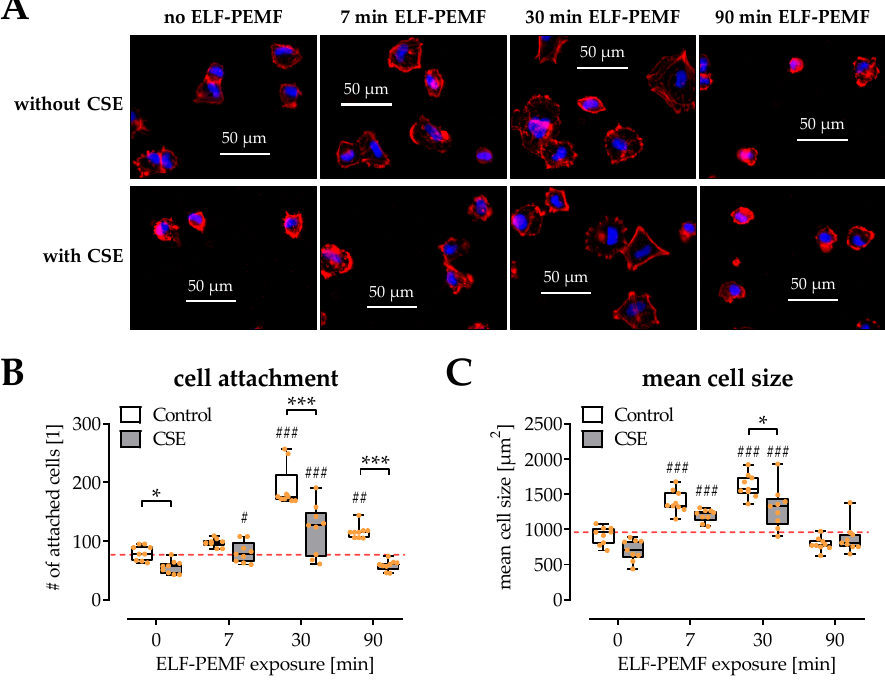
Figure 2. Influences of 16 Hz ELF-PEMFs (0, 7, 30, and 90 min) and 5% cigarette smoke extract (CSE) on SCP-1 cell adhesion and spreading after 4 h. ( A ) Representative images (400 × magnification) of the fluorescence staining for cytoskeleton (phalloidin-TRITC, 2 μg/mL, red) and nuclei (Hoechst 33342, 2 μg/mL, blue). ( B ) Automated quantification of adherent nuclei, and ( C ) the mean size of attached SCP-1 cells using the ImageJ software. N = 3, n = 3. Data are presented as box plots (Min to Max with single data points). Data were compared by non-parametric two-way ANOVA followed by Tukey’s multiple comparison test: * p < 0.05 and *** p < 0.001 as indicated; # p < 0.05, ## p < 0.01, and ### p < 0.001 as compared to the respective control (no